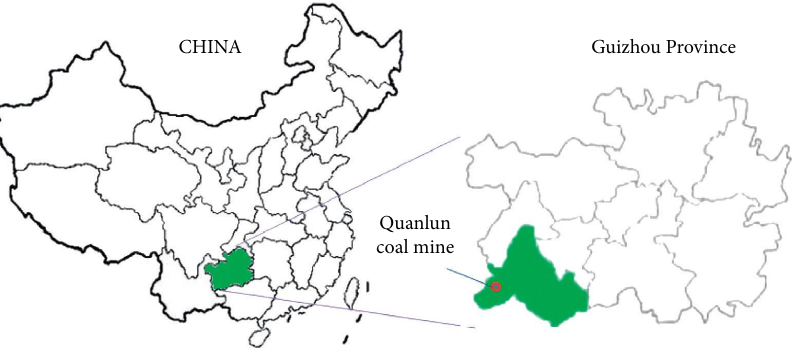
Figure 2: Te geographical location of the Quanlun coal